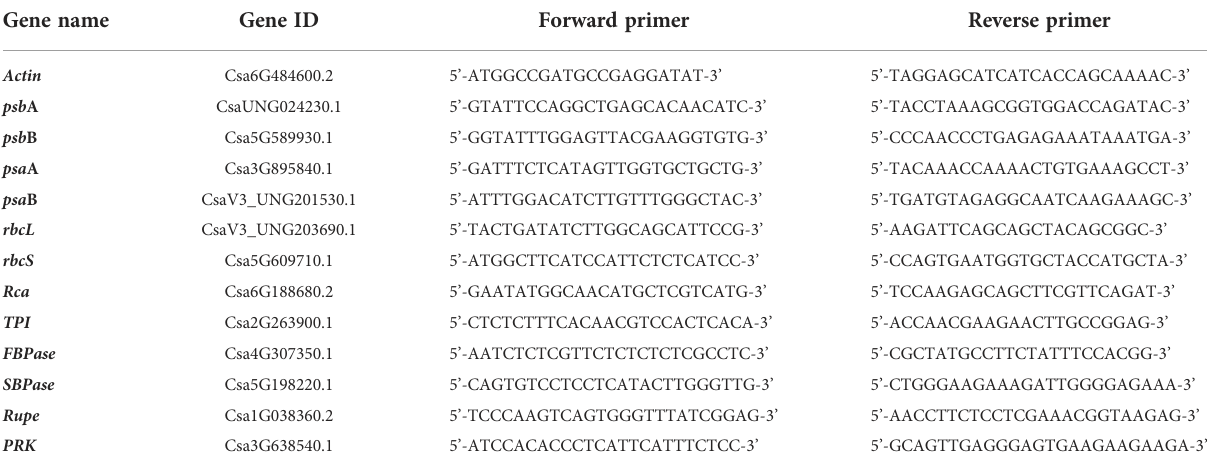
TABLE 1 Primers used for